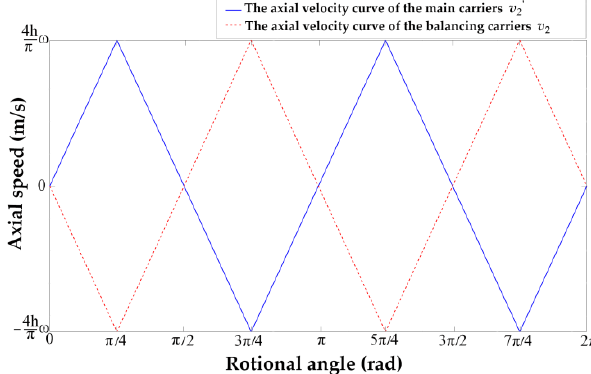
Figure 3. The axial velocities of the left carriers: ( a ) θ ∈ ( 0 ， π ， 2π ) .